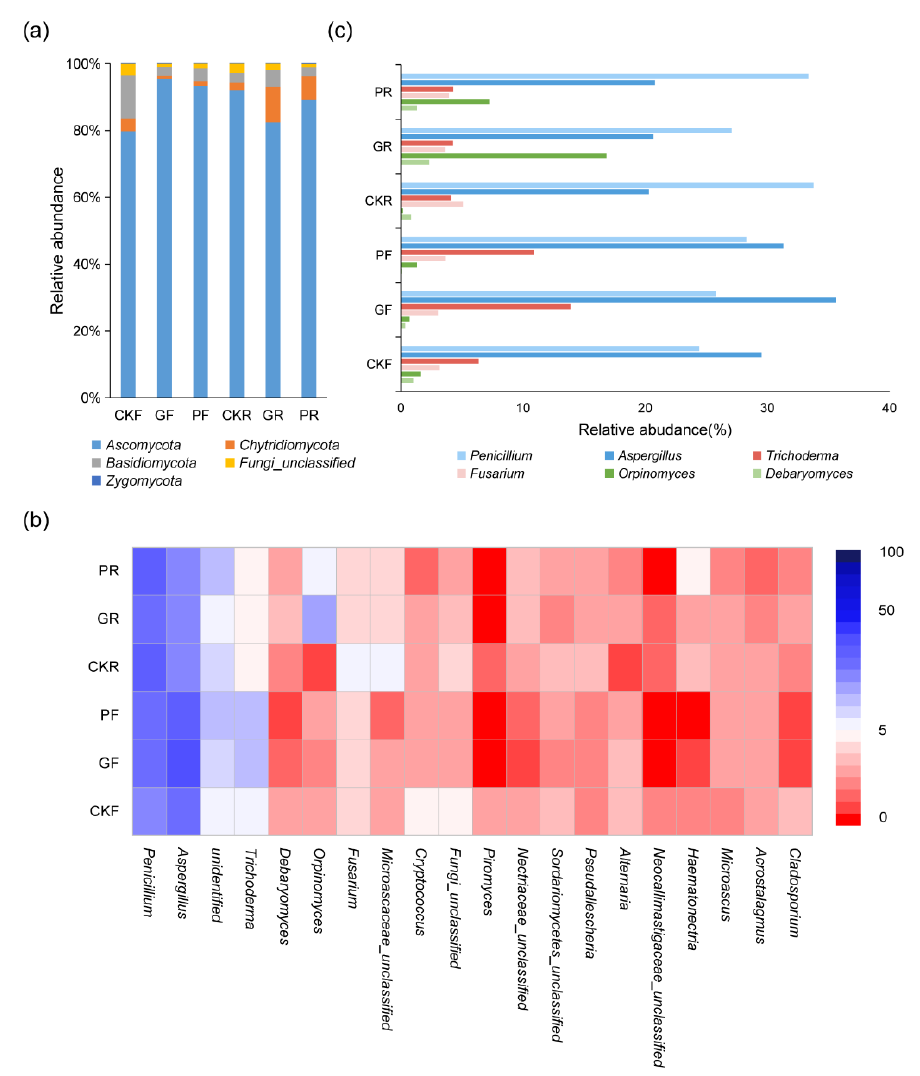
Figure 5. The influence of different treatments on the fungal community structure in the rumen and feces of dairy cows. ( a ) The fungal community structure composition at phylum level, ( b ) The top 20 fungal genera in relative abundance in dairy cow samples, ( c ) Relative abundance of dominant genera. F: feces sample. R: rumen sample.